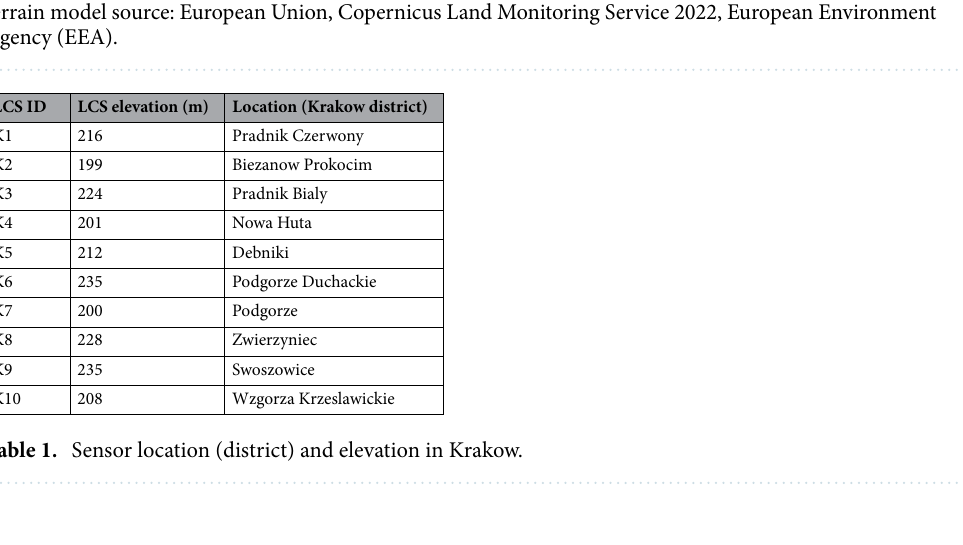
Figure 1. Krakow topography map (digital terrain model) with Airly sensor locations and their IDs (white rectangle), together with the borders of Krakow districts (grey lines and the main rivers (blue lines). Digital